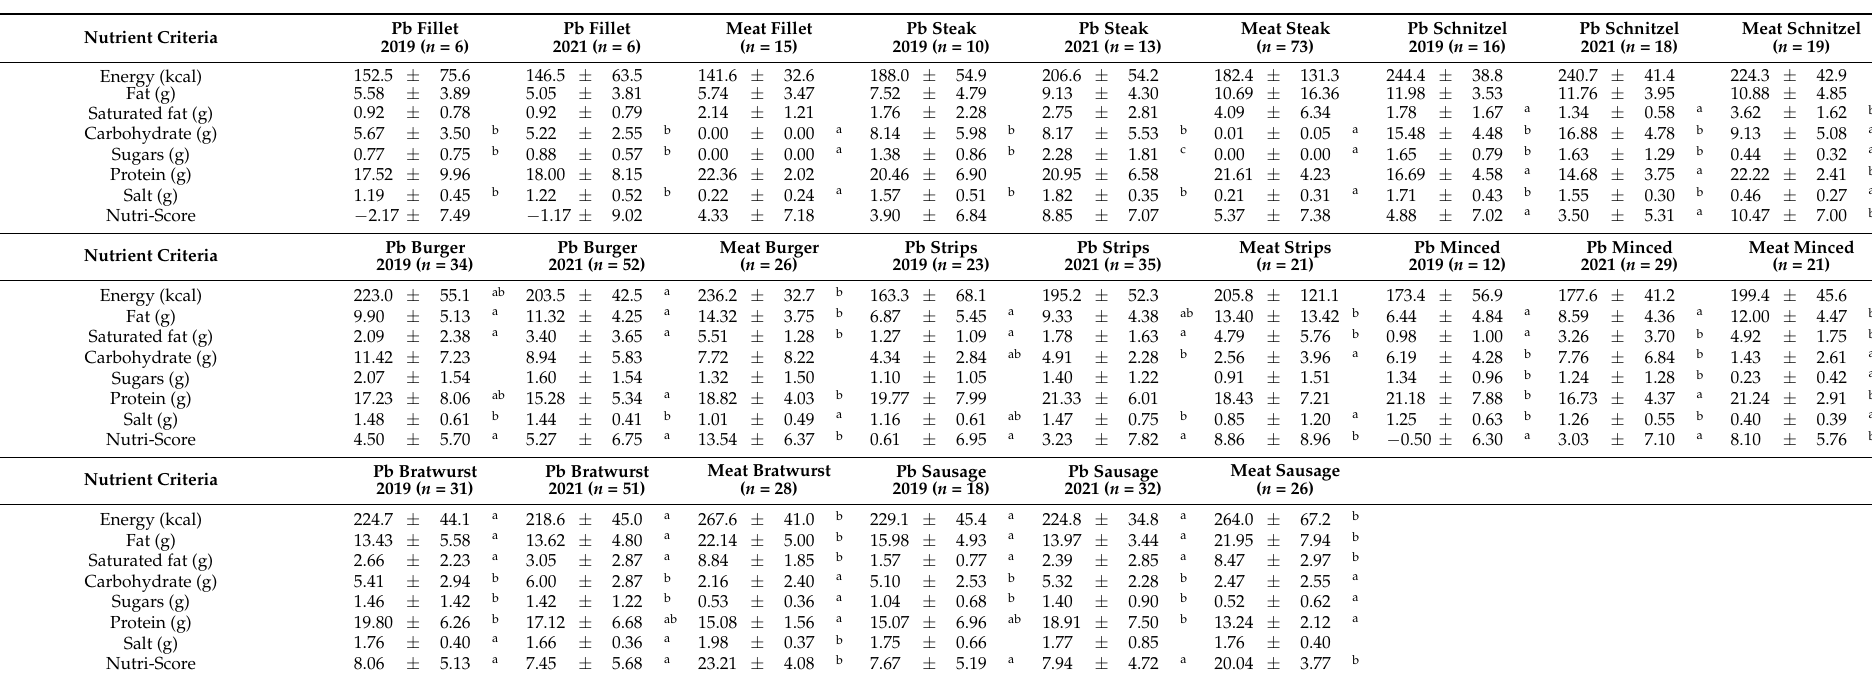
Table 4. Nutrients (“Big 7”) and Nutri-Score per 100 g of pb meat alternatives and meat (mean and standard deviation) in eight different food groups, compared to animal-based products